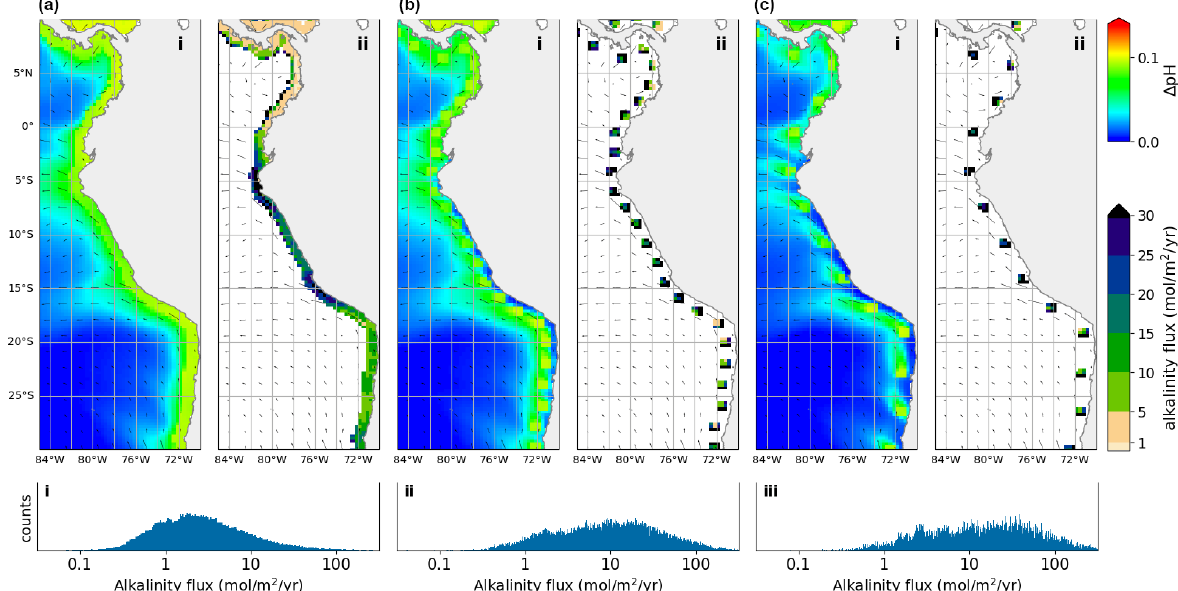
Figure 4. Alkalinity enhancement in three different patterns, exemplified at the west coast of South America: (a) Injection in a contiguous strip. (b) Injection in 200km separated patches. (c) Injection in 400km separated patches. The total globally area-integrated OAE rate for the three injection patterns was (a) 336Tmolyr − 1 , (b) 312Tmolyr − 1 and (c) 233Tmolyr − 1 , respectively. The sub panels show (i) time averaged pH change, (ii) alkalinity flux, (iii) distribution of alkalinity flux (globally).